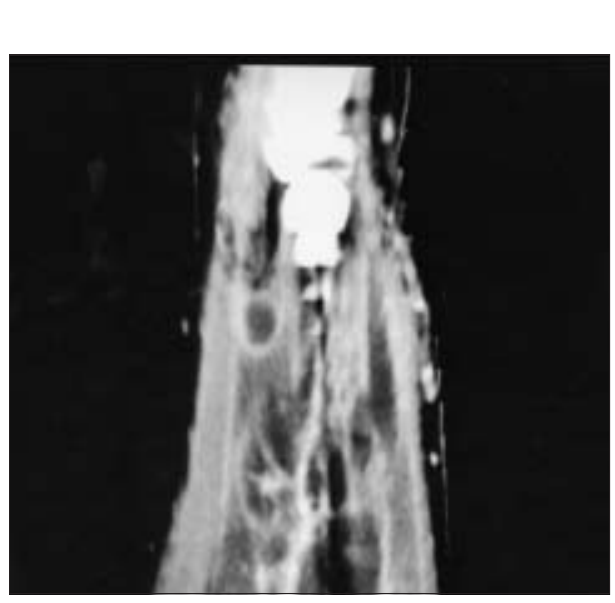
Figure 1) Enhanced sagittal image of the right forearm, showing mul- tiloculated low attenuation in the interosseous space (with peripheral enhancement), extending both dorsally and